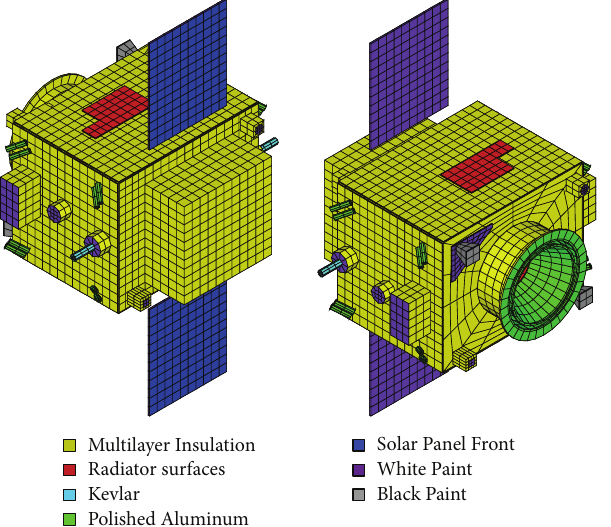
Figure 5: Definition of surface materials in the FE model of MICROSCOPE. ⃗𝐹| Figure 6: | SRP as function of incident sunray in polar coordinates 𝜑 and 𝜃 with a constant value of 𝑃 for the FE model of MICRO- SCOPE.